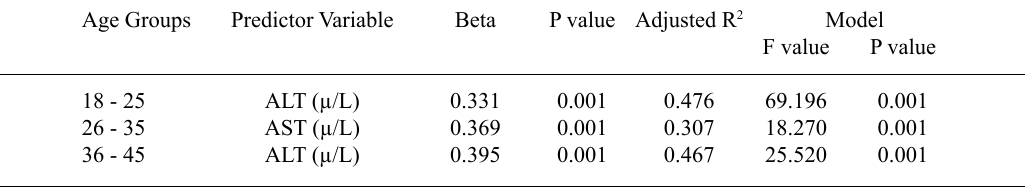
Table 4. Multiple regression using stepwise method for Igg as a dependent variable